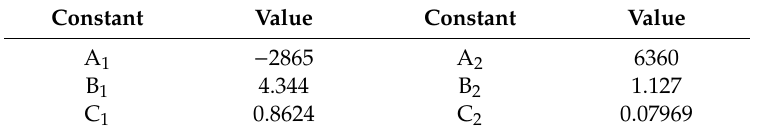
Table 2. The constants values used in the methodology of desiccant air-conditioning (DAC) system. Constant